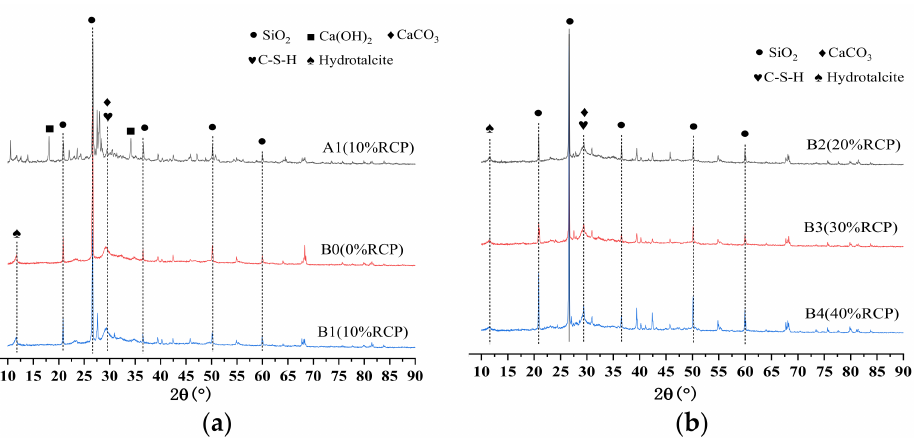
Figure 10. XRD patterns of mortar with different contents of RCP. (( a ) XRD patterns of A1, B0 and B1, ( b ) XRD patterns of B2, B3 and